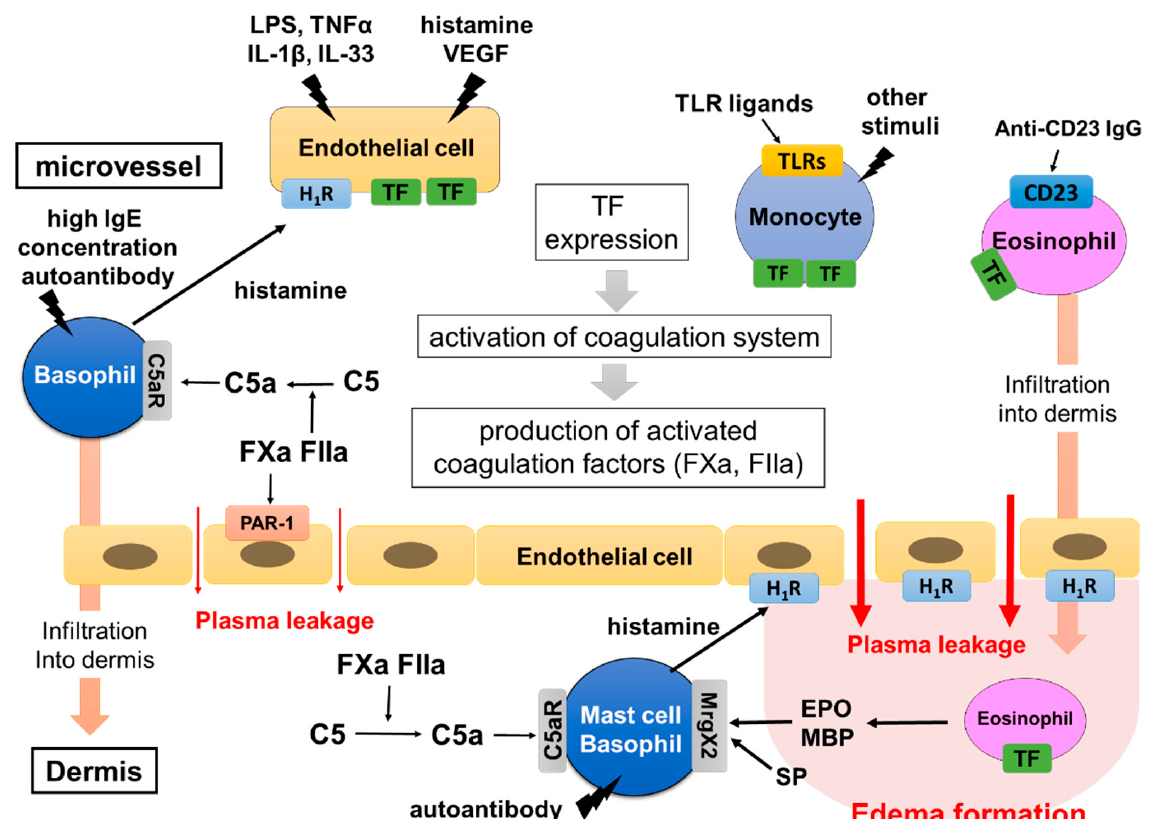
Figure 3. Hypothetical mechanism of edema formation triggered by TF in CSU. TF inducers, such as VEGF, TNF, IL-33, TLR ligands and anti-CD23 antibody, induce TF expression of vascular endothelial cells, monocytes and eosinophils. Histamine released from basophils in response to high IgE concentrations (>1 µ M) may contribute to the synergistic expression of TF on vascular endothelial cells. The high expression of TF then activates the extrinsic coagulation system and produces active forms of the coagulation factors, such as FXa and FIIa. They induce plasma leakage via PAR-1 expressed on vascular endothelial cells and produce C5a from C5 in the intravessel and dermis. C5a leaks from blood vessels and is newly produced from plasma being exposed to eosinophils expressing TF in the tissue, then activating skin mast cells. Finally, skin mast cells release a large amount of histamine, which forms edema and flare via H1R. Basophils and monocytes stimulated with C5a, and eosinophils stimulated with anti-CD23 antibodies, may induce infiltration of the cells into the dermis and contribute to the exacerbation of edema formation.